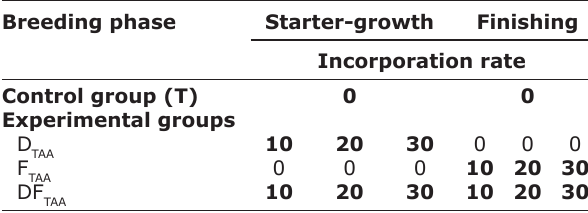
Table-1: Arrangement of the different groups according to the rate of incorporation of apricot kernel cake (TAA) and the rearing